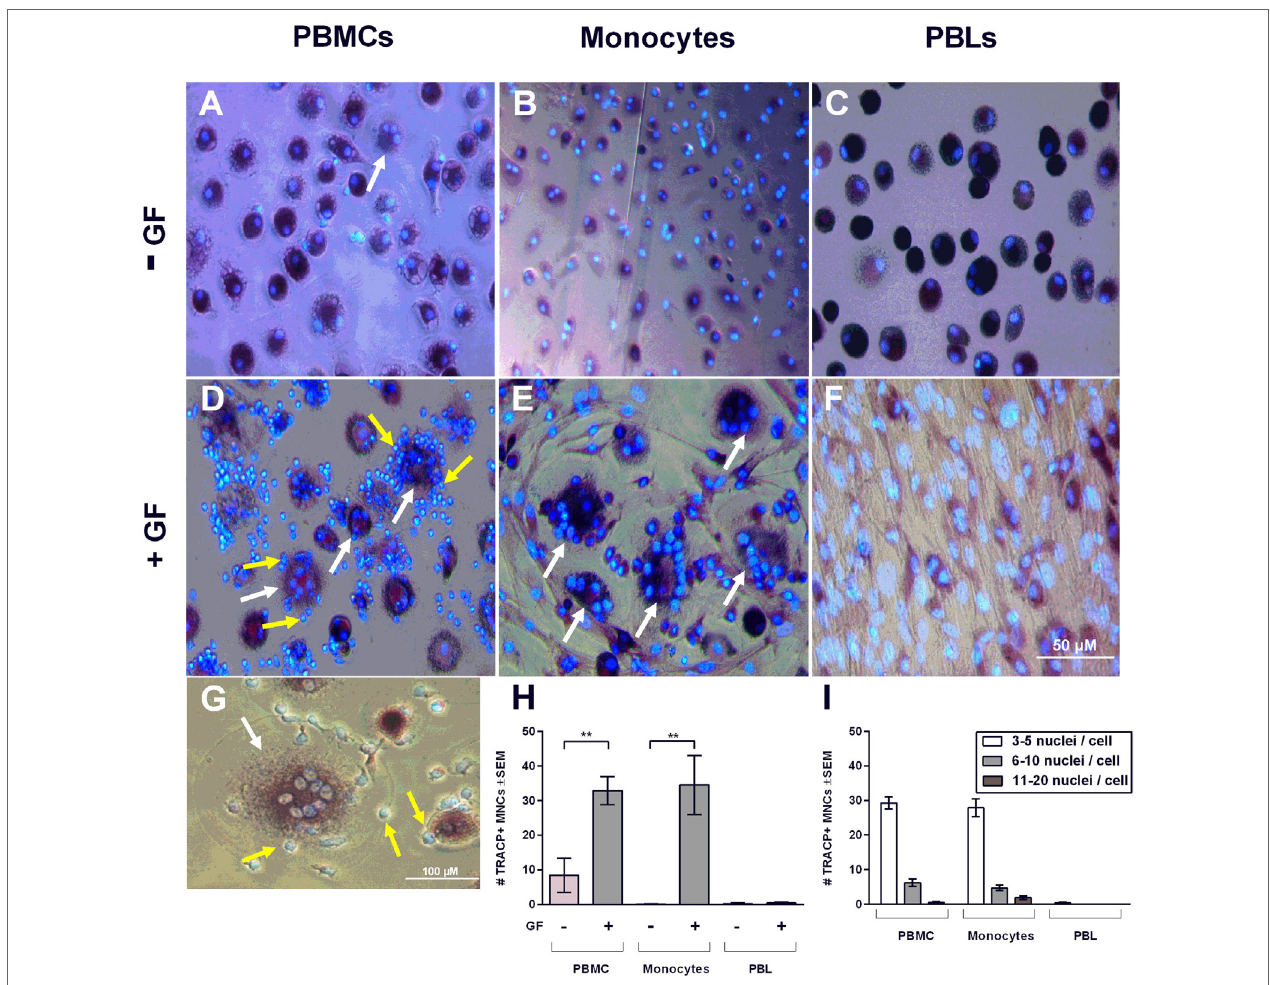
FigUre 2 | Gingival fibroblasts (GFs) enhance osteoclastogenesis in the presence of monocytes. Micrographs of monocultures of (a) peripheral blood mononuclear cell (PBMCs), (B) monocytes, and (c) peripheral blood lymphocytes (PBLs) after 21 days. Micrographs of cocultures of GFs with (D) PBMCs, (e) monocytes, and (F) PBLs after 21 days of culture. Cells were stained for TRACP activity (purple) and nuclei were stained with 4 ′ ,6-diamidino-2-fenylindool (blue). TRACP + multinucleated cells (MNCs) were considered to be osteoclasts when TRACP + with at least three nuclei. Osteoclasts are depicted with white arrows and are exclusively visible in conditions with cocultures of GFs with PBMCs and monocytes (D,e) . All micrographs are representatives for four independent experiments with seven different GF sources. Scale bar represents 50 µM. (g) Osteoclast (white arrow) present in coculture of GFs with PBMCs. Interacting TRACP-negative mononuclear cells with osteoclasts are depicted with yellow arrows (D,g) . Scale bar represents 100 µM. (h) Quantification of the number of TRACP + MNCs per five standardized pictures per well in monocultures and cocultures of PBMCs, monocytes, or PBLs after 21 days. Significantly more osteoclasts were found in cocultures of GFs with PBMCs or monocytes when compared to monocultures, n = 4 GF donors, ** p < 0.01. (i) Number of nuclei per TRACP + cell in GF cocultures with PBMCs, monocytes, and PBLs after 21 days. Mainly, osteoclasts with 3–5 nuclei were found in cocultures with